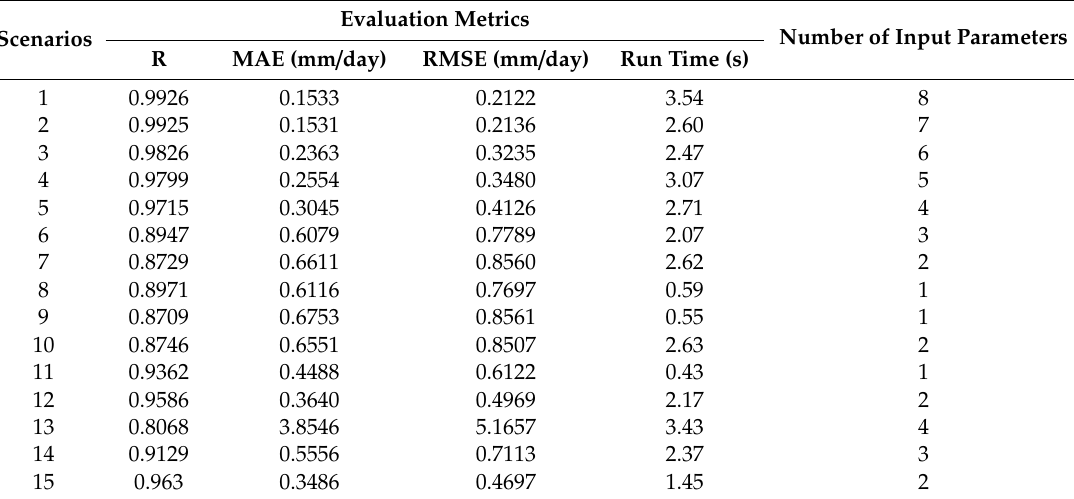
Table 5. RF model results for di ff erent scenarios.